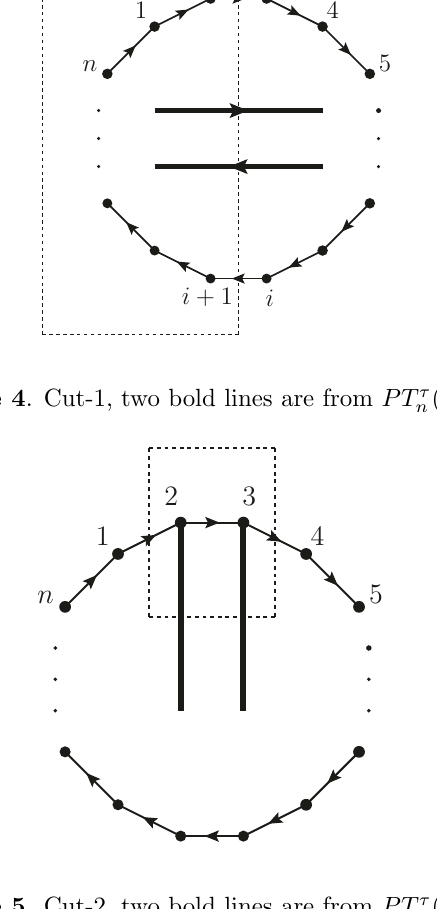
Figure 5 . Cut-2, two bold lines are from PT (cid:28)